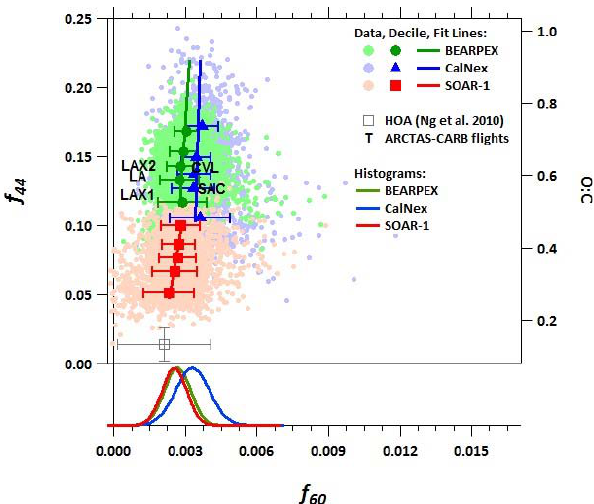
Fig. 1. Upper Panel: f 44 as a function of f 60 for measurements with little or negligible BB influence. Coloured points represent data from the ground campaigns SOAR-1, BEARPEX and CalNex-LA, and are also shown binned to quintiles for clarity. Text represents averaged periods from the ARCTAS-CARB mission: LA=Los Angeles overpass, LAX=missed approach on LAX, CVL=San Joaquin valley, SAC=Sacramento overpass. Also shown is the av- erage hydrocarbon-like OA across 15 urban studies (and its variabil- ity) from Ng et al. (2011b) for reference. Lower Panel: Normalised histograms of f 60 for the three ground campaigns. Note that the f x quantities are dimensionless as they are ratios of two concentrations with the same